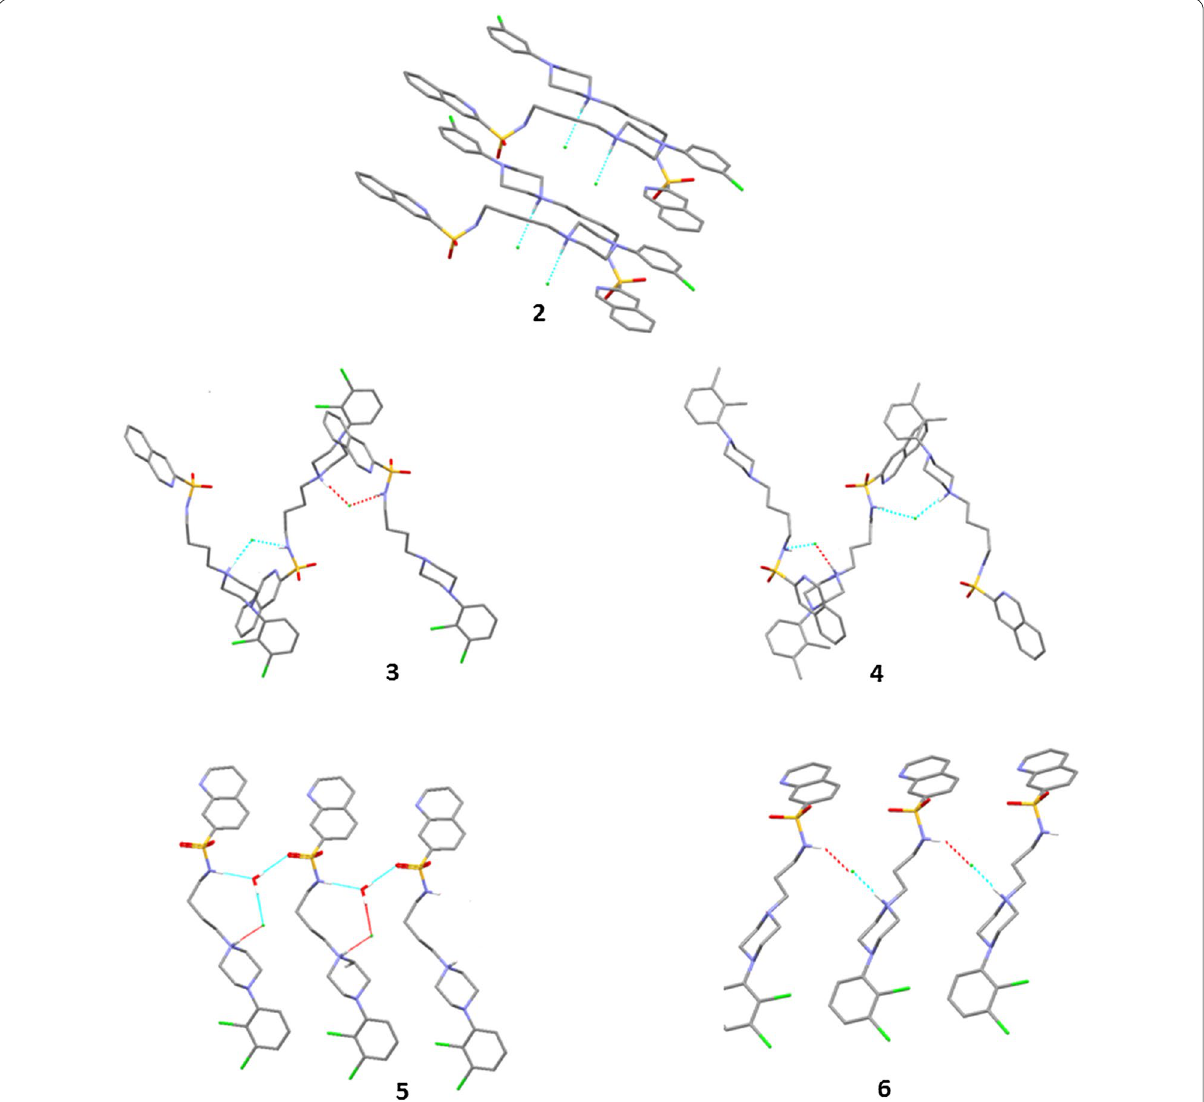
Fig. 4 Crystal packing of azinesulfonamides 2 – 6 . Hydrogen atoms not involved in the hydrogen bond patterns were removed for